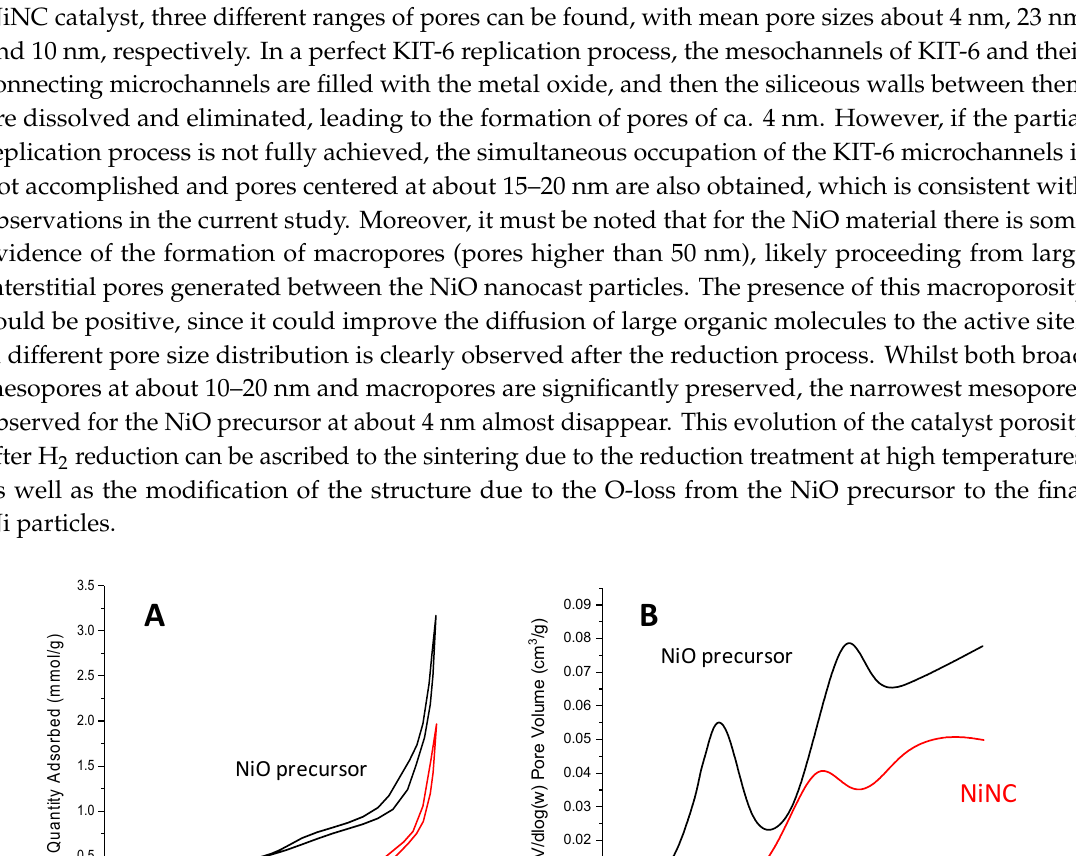
Figure 5. Temperature programmed reduction of nickel oxide precursors prepared by different preparation procedures. For all precursors, a main peak with a shoulder at higher temperatures is observed, which has been associated with larger NiO particles [38,39] due to certain heterogeneity in the samples. It must be noted that the hydrogen consumption in the TPR experiments adjusts with the NiO  Ni transition with a low error (±6%).